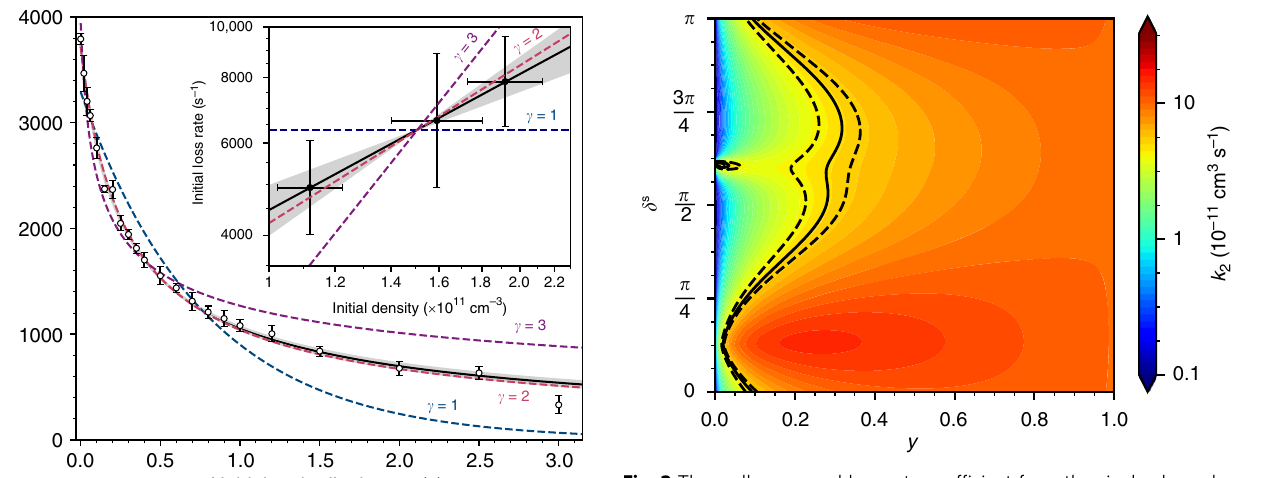
Fig. 2 Thermally averaged loss rate coef fi cient from the single-channel model at 1.5 μ K. k 2 ( T ) is plotted as a function of the loss parameter y and the short-range phase shift δ s . The solid and dashed black lines correspond to the measured k 2 and